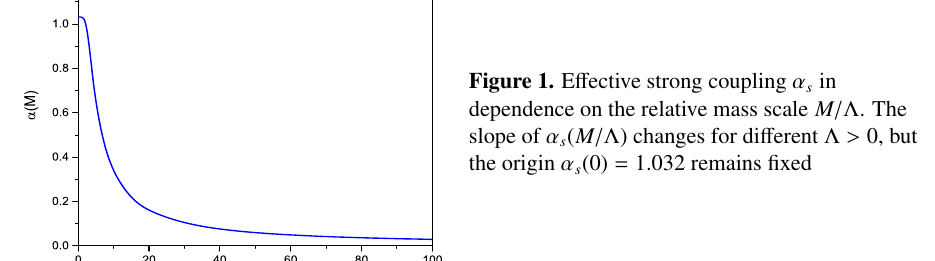
Figure 1. E ff ective strong coupling α s in dependence on the relative mass scale M / Λ . The slope of α s ( M / Λ ) changes for di ff erent Λ > 0, but the origin α s (0) = 1 . 032 remains